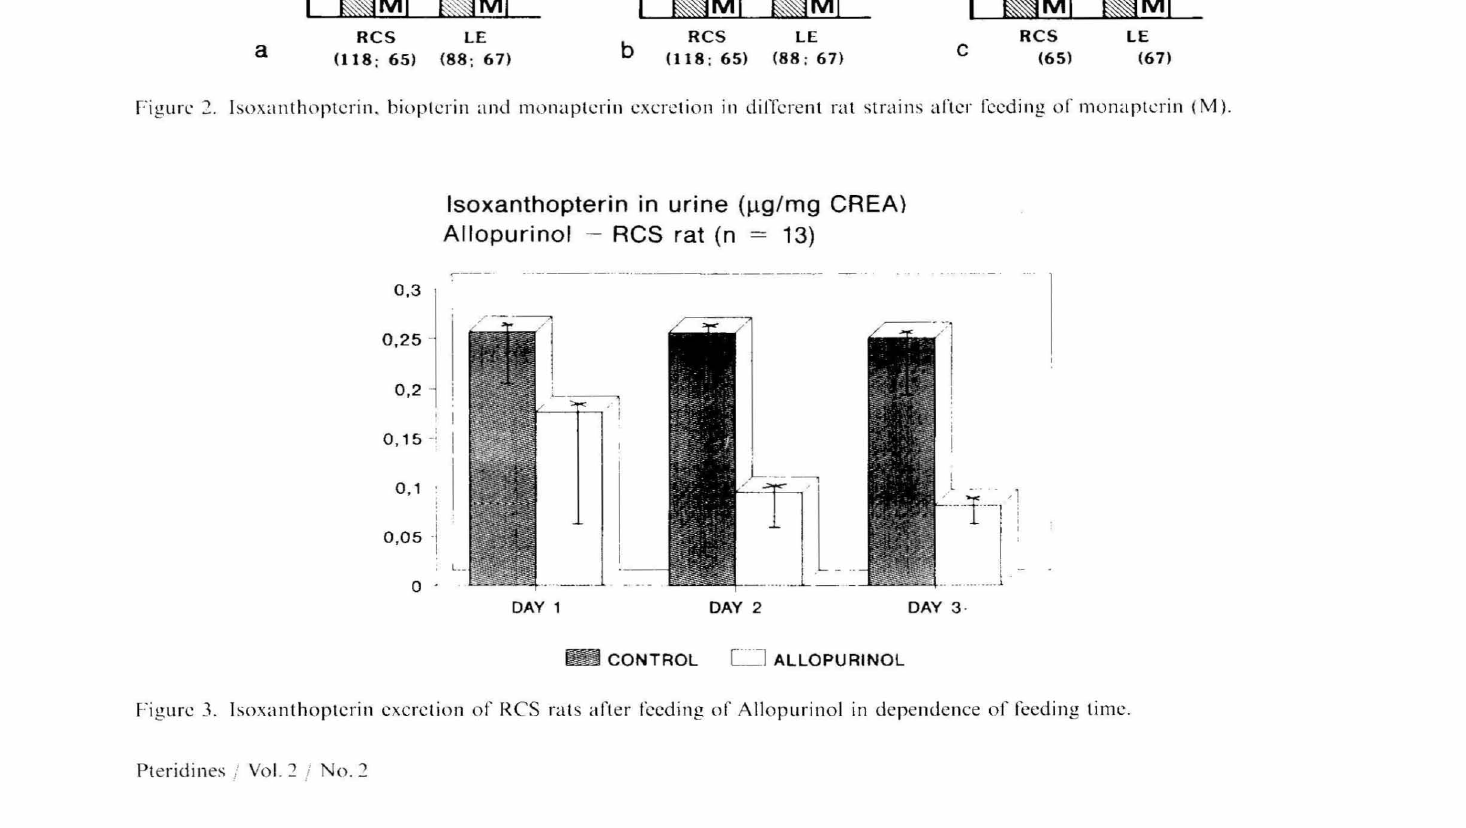
Figure 3. Isoxanthopterin excretion of RCS rats aner lCeding of AllopLlrinol in dependence of feeding time. Pteridines ! Vol. 2 ! o.